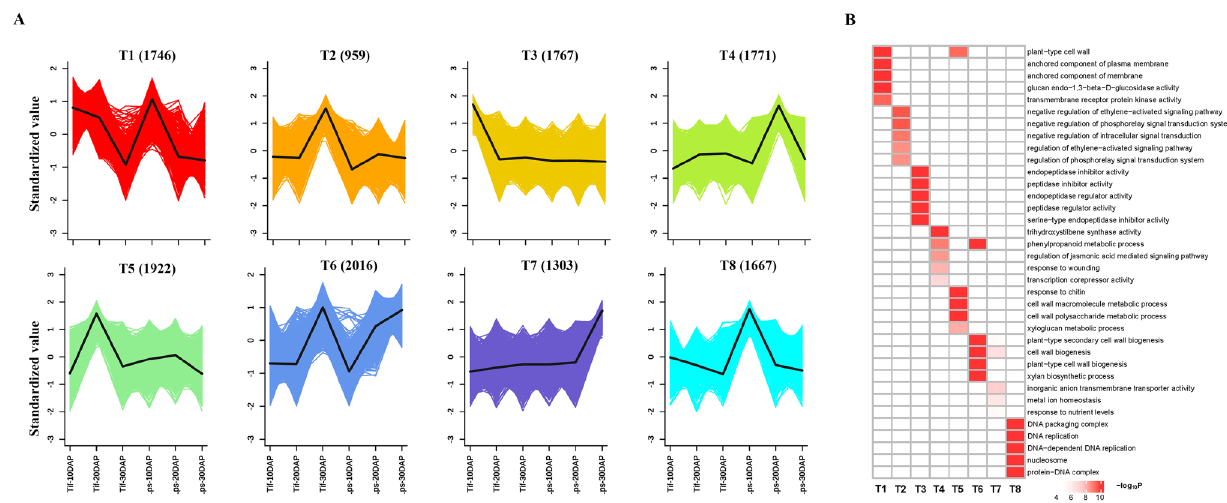
DAMs. The larger the radius of the circle, the higher the value of VIP. ( D ) UpSet plot of three different comparison groups. The vertical axis represents the number of DAMs. ( E ) k-means clustering analysis on DAMs. Numbers in parentheses represent the number of DAMs per cluster. Each color line corresponds to a metabolite. The x axis represents Tif and Lps at three growth stages and the y axis depicts the standardized value of relative metabolite content. ( F ) KEGG enrichment analysis for DAMs of the 8 clusters.